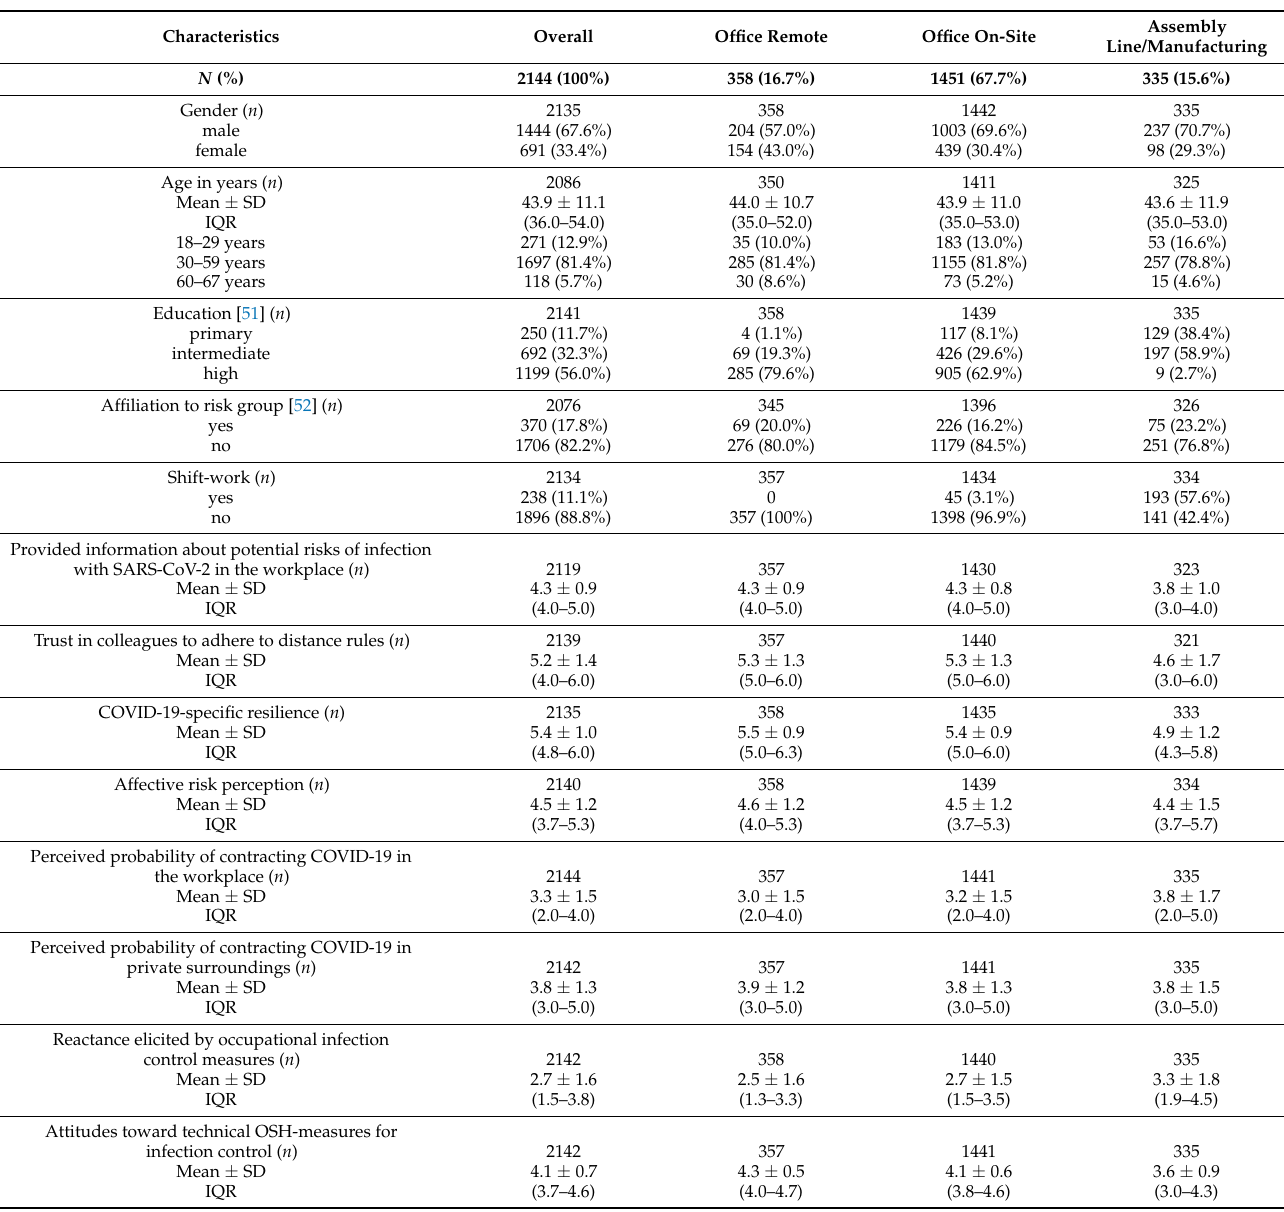
Table 1. Socio-demographic and work-related characteristics at baseline: overall, and com- pared between predominantly remotely working office, on-site working office, and assembly line/manufacturing